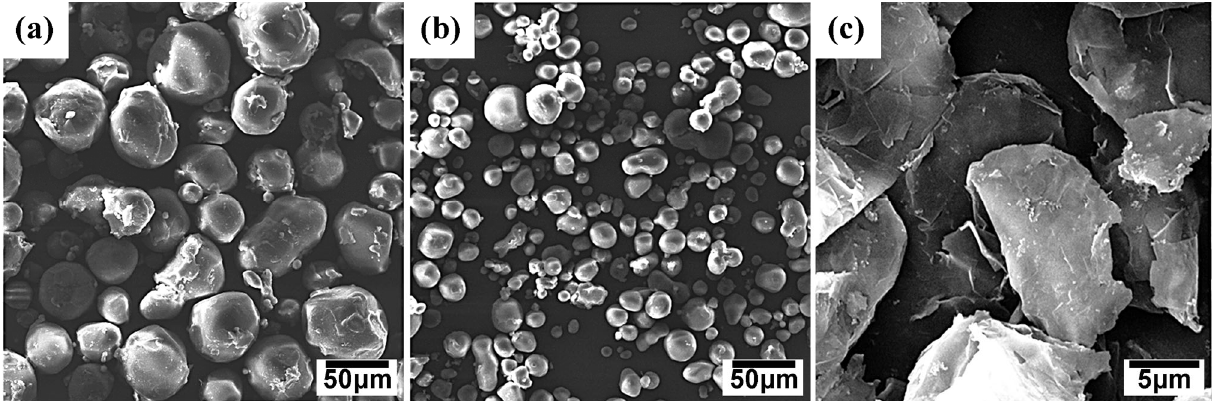
Figure 2. SEM micrographs of PA6 microspheres ( a ), PA612 microspheres ( b ) and graphite sheets ( c ).